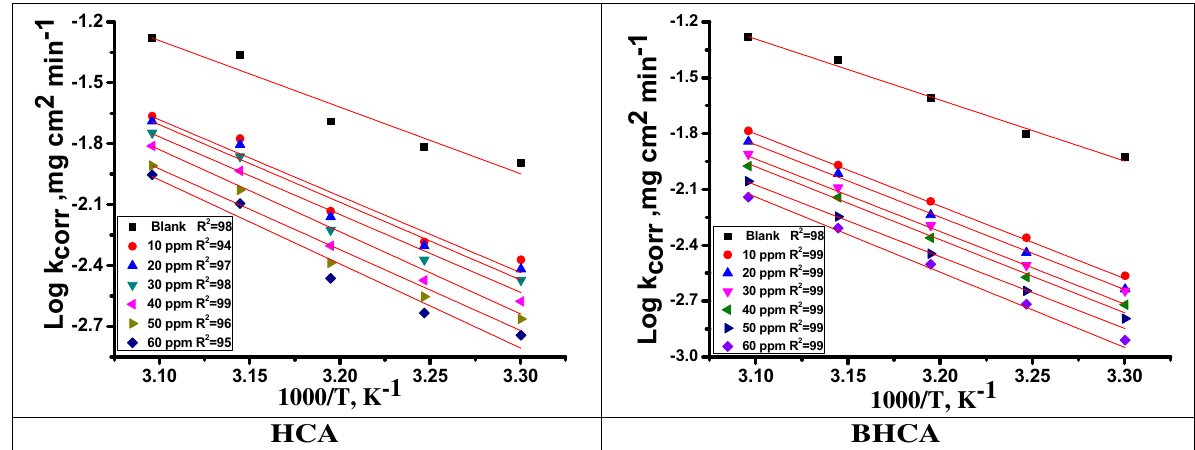
Figure 5. Arrhenius plots for dissolution of CS in 1 M HCl without and with of altered concentrations of HCA